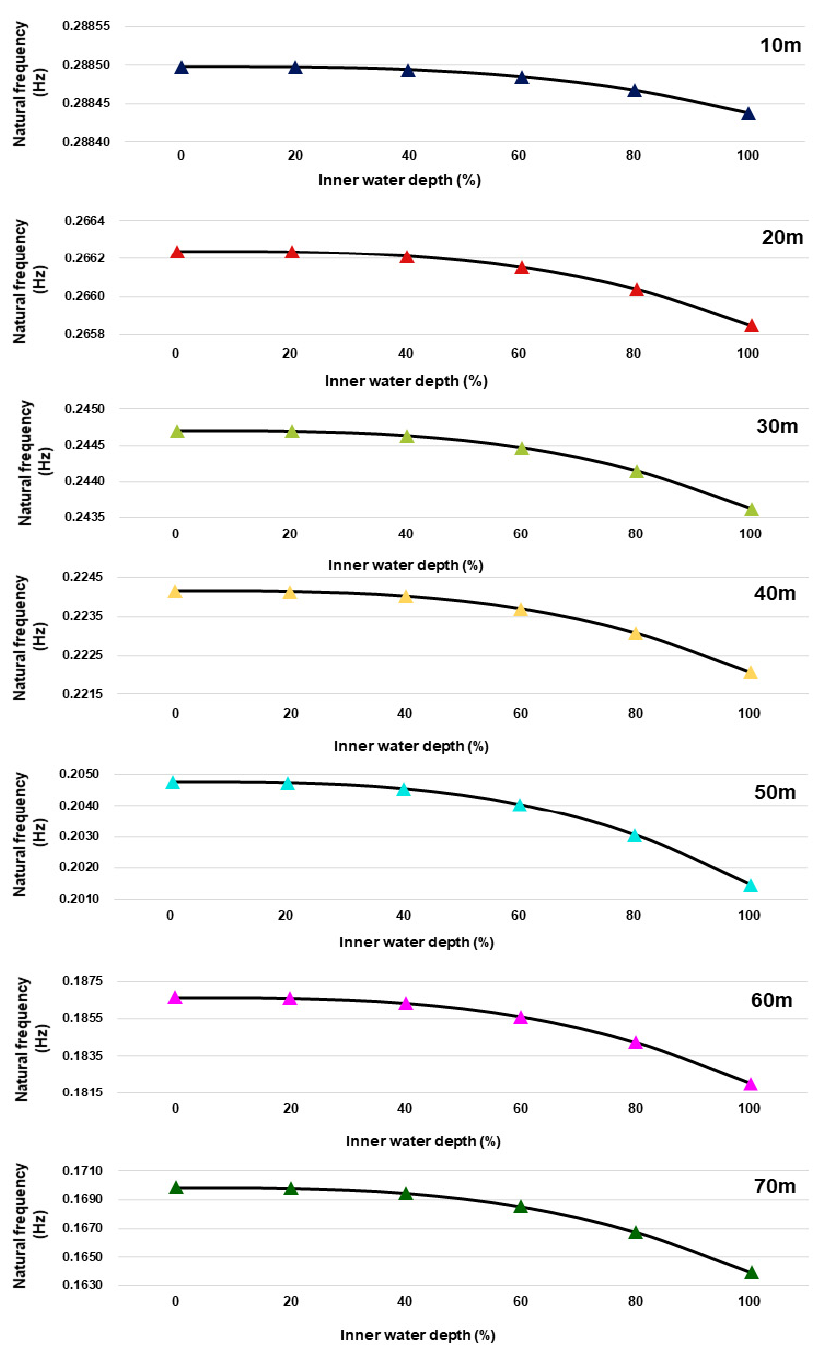
Figure 7. The natural frequency according to the change of